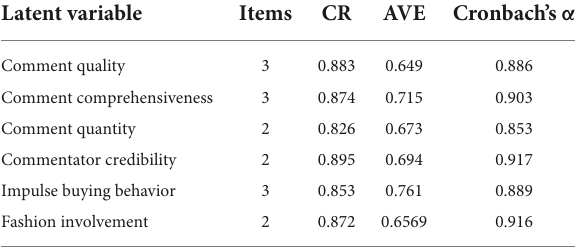
TABLE 3 Reliability test of the scale.